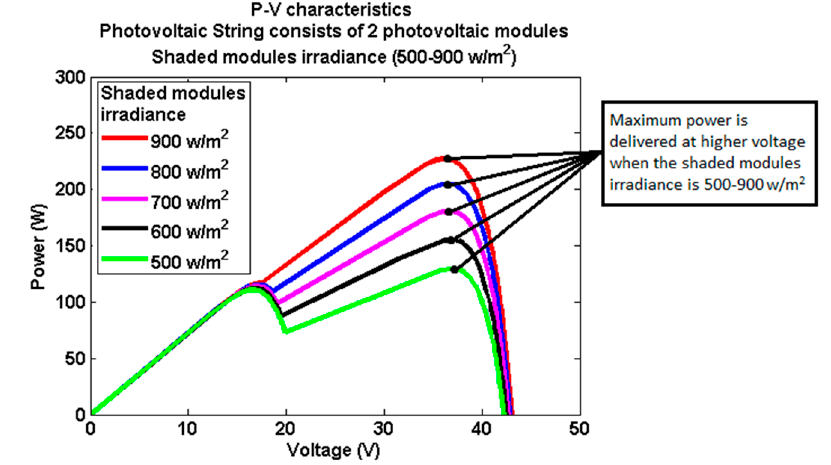
Figure 23. Simulated P-V characteristics of photovoltaic string in Figure 22—shaded module irradiance is between 500 and 900 w/m 2 .